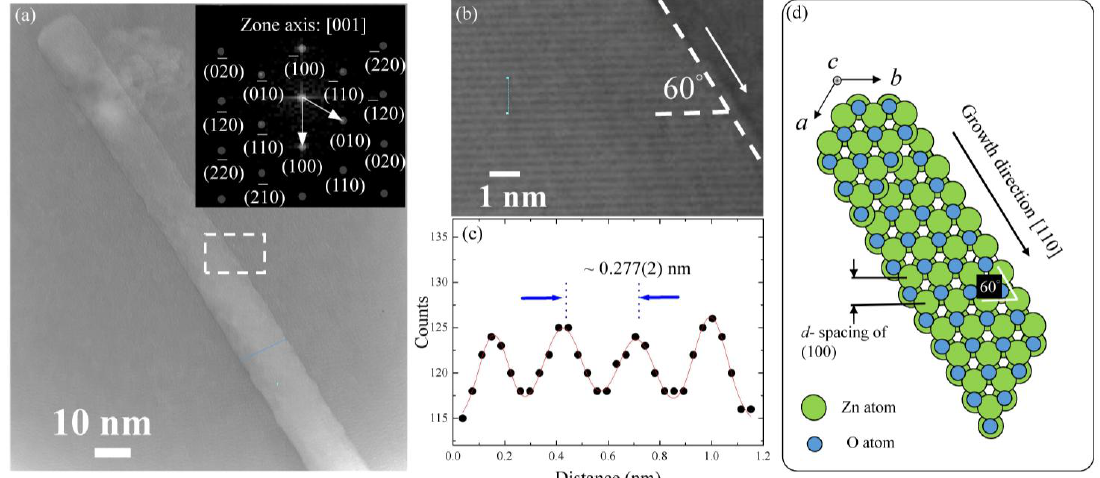
Figure 1. ( a ) Transmission electron microscopy (TEM) images of an individual straight ZnO nano-wire (NW). The inset to ( a ) is the electron diffraction pattern of a selected area of the nanowire, revealing the hexagonal structure of ZnO; ( b ) high-resolution transmission electron microscopy (HR-TEM) image of the selection region (marked in ( a )) of ZnO NW; ( c ) height-position intensity along the line taken from HR-TEM (marked in ( b )); and ( d ) schematic plot of the atomic model for a single ZnO NW.